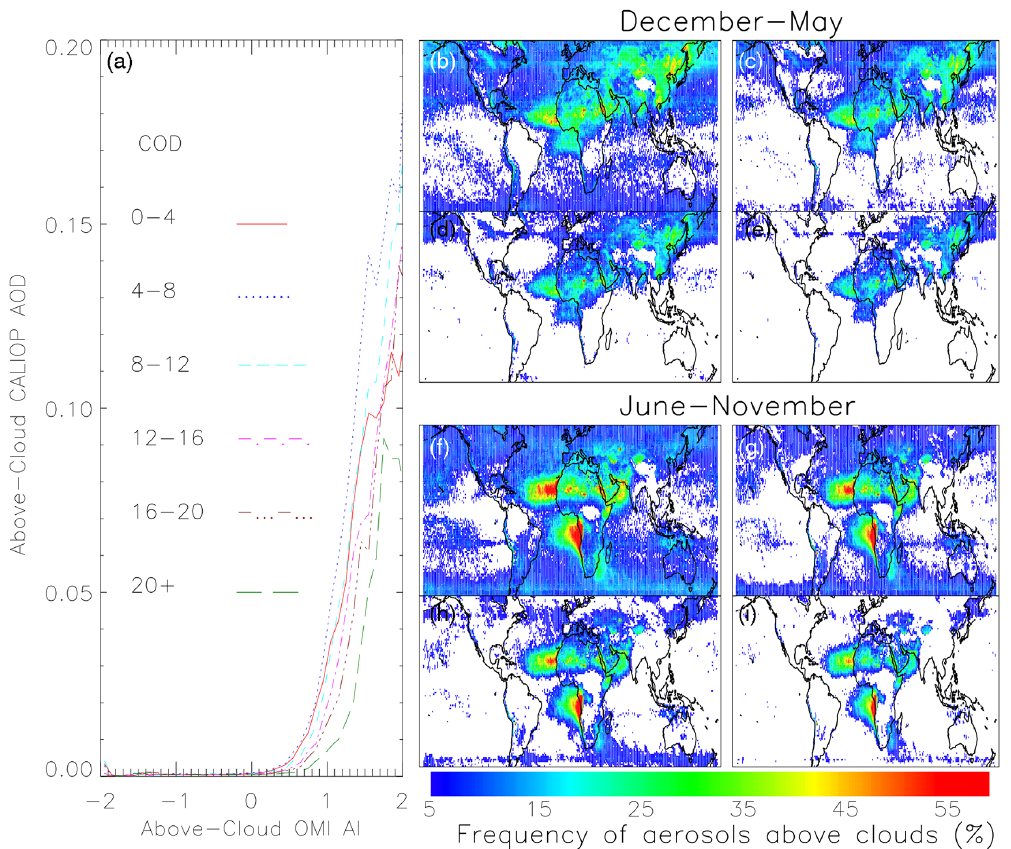
Figure 2. (a) Pairwise comparison between collocated OMI and CALIOP observations of above-cloud AI and AOD, respectively, as a function of the underlying MODIS cloud optical depth (COD). CALIOP AODs are averaged into OMI AI bins of 0.1. (b–i) Multi-year (2006–2013) daytime global cloudy-sky ACA frequency applying several different OMI AIs as the threshold between background and significant aerosol loading. The OMI AIs are binned into 1 ◦ × 1 ◦ bins derived from the MODIS-OMI collocated data set. OMI AI baseline thresholds of 0.7, 0.8, 0.9, and 1.0 are applied to (b, c, d, e) , respectively, for the December–May period. Panels (f–i) depict the same information as (b–e) but for the June–November period. ACA frequencies less than 5% are shown in